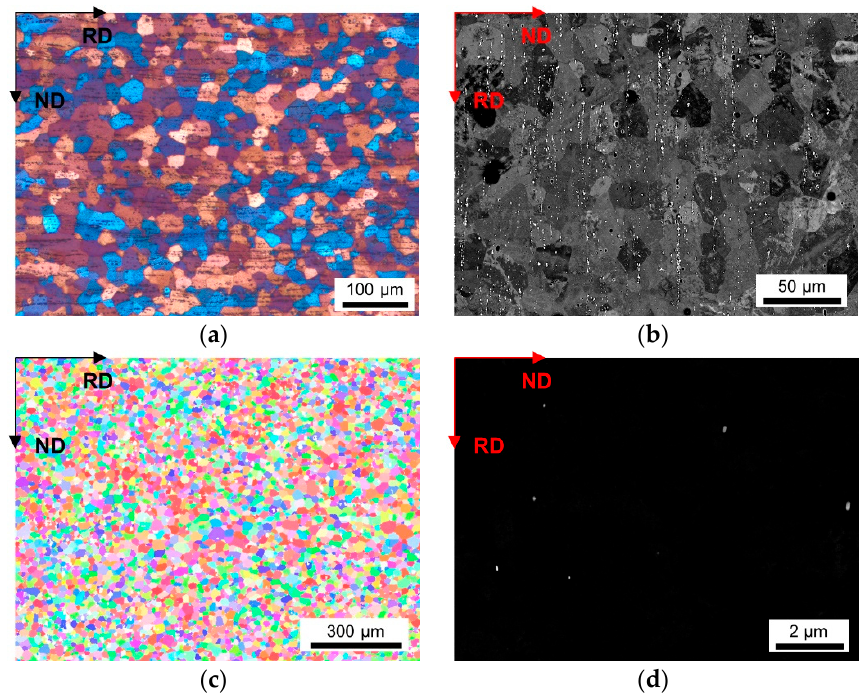
Figure A22. Microstructure of the soft annealed HFe-LMn cast under NR-C conditions, homogenized at 550 °C and cold rolled to a CRD of 35%. ( a ) LOM. ( b ) BSE image. ( c ) EBSD IPF map in RD–ND plane. ( d ) BSE micrograph showing dispersoids.